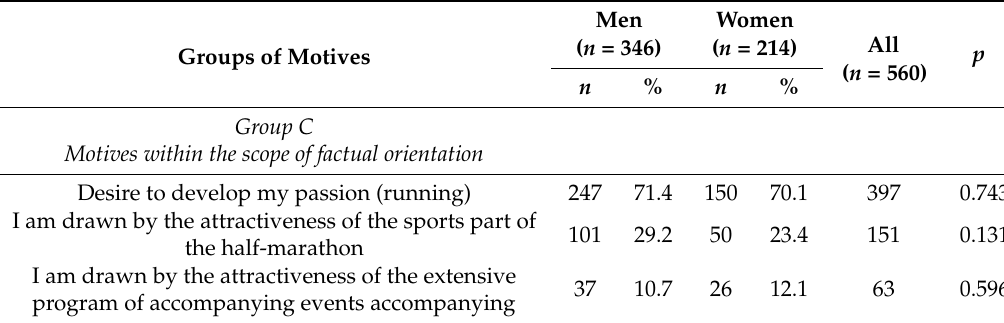
Table 9. Motives within the scope of factual orientation.